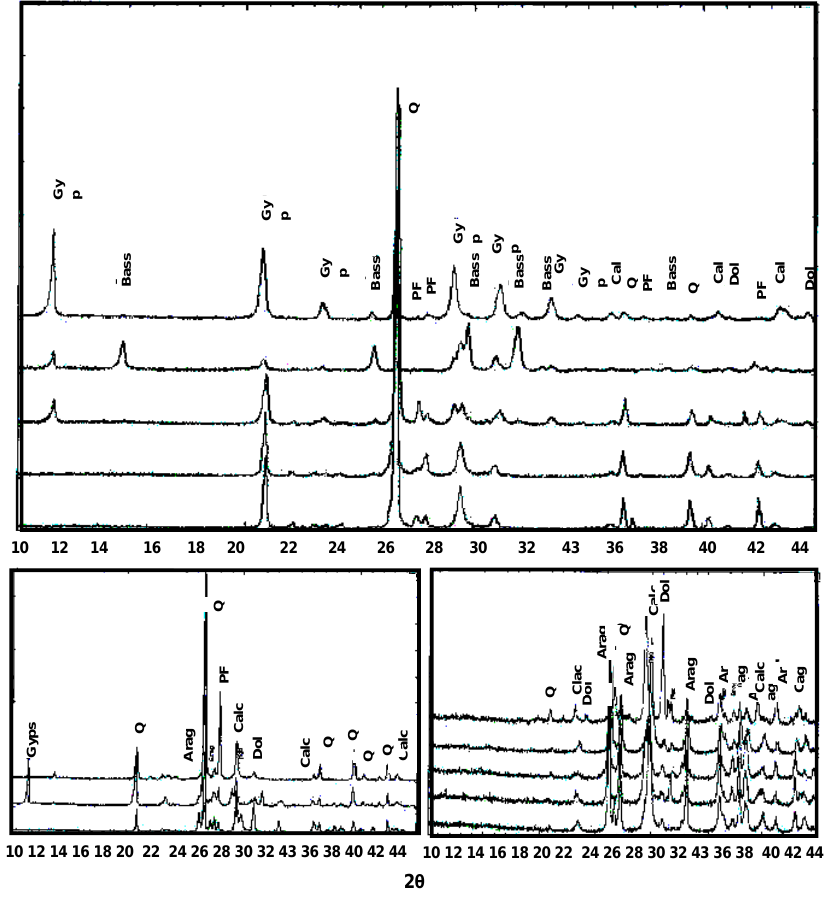
Figure 10. XRD analysis for: (a) west sabkha-derived sand, (b) northeast beach-derived sand and (c) southeast sand dunes of Qatar Peninsula (Gyp: Gypsum; Bass: Bassanite; Q: Quartz , P-PF: Plagoclase-Feldespar; Cal: Calcite; Dol: Dolomite; Arag: Aragonite).